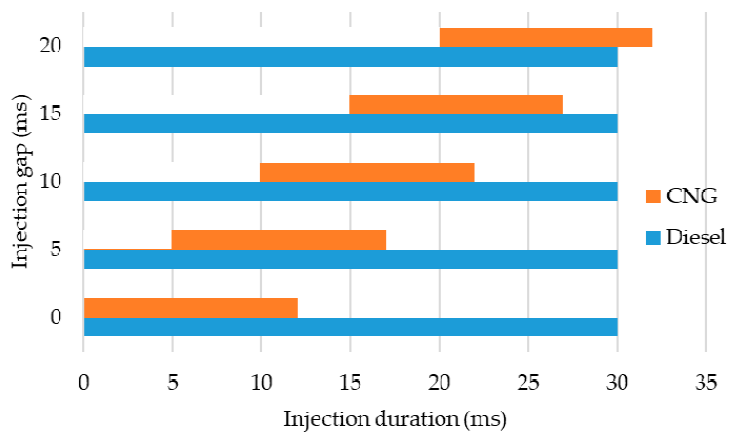
Figure 6. Injection timing illustration for 60/40 diesel/CNG composition.